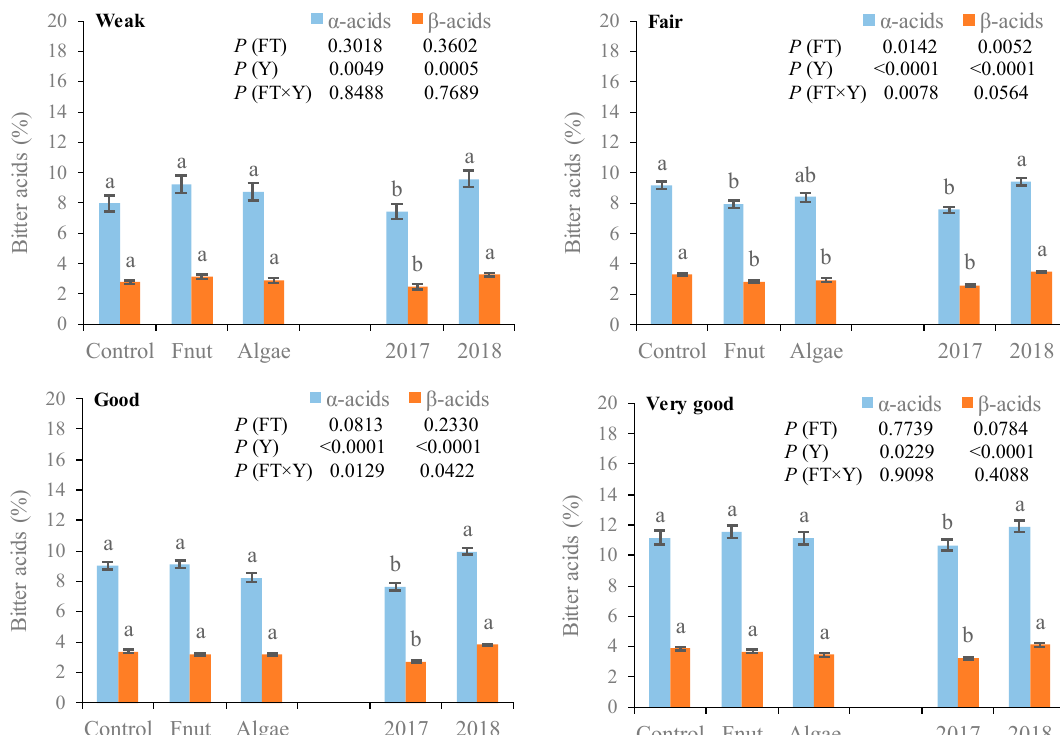
Figure 4. Cone α - and β -acid concentrations (average ± standard error) in the different plant vigour plots (Weak, Fair, Good and Very good), as a function of foliar treatment (Fnut, nutrient-rich foliar spray; Algae, algae-rich foliar spray; and Control) and year. Means followed by the same letter are not statistically different ( α = 0.05) by Tukey HSD tests (Foliar treatment) or Student’s t-tests (Year).